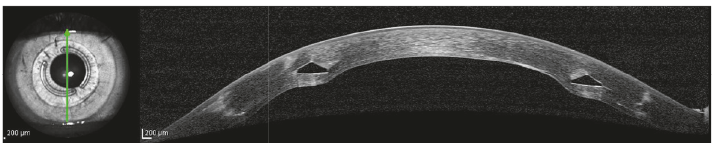
Figure 5: Optical coherence tomography (OCT) of the cornea one year after the procedure, showing the position of the ICRS.